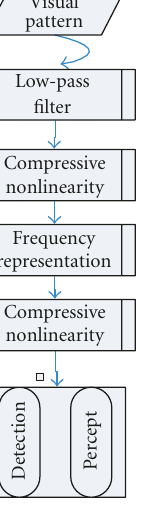
Figure 3: The schematized framework of visual image processing for pattern detection and brightness perception. The output of the last nonlinearity shows cortical information